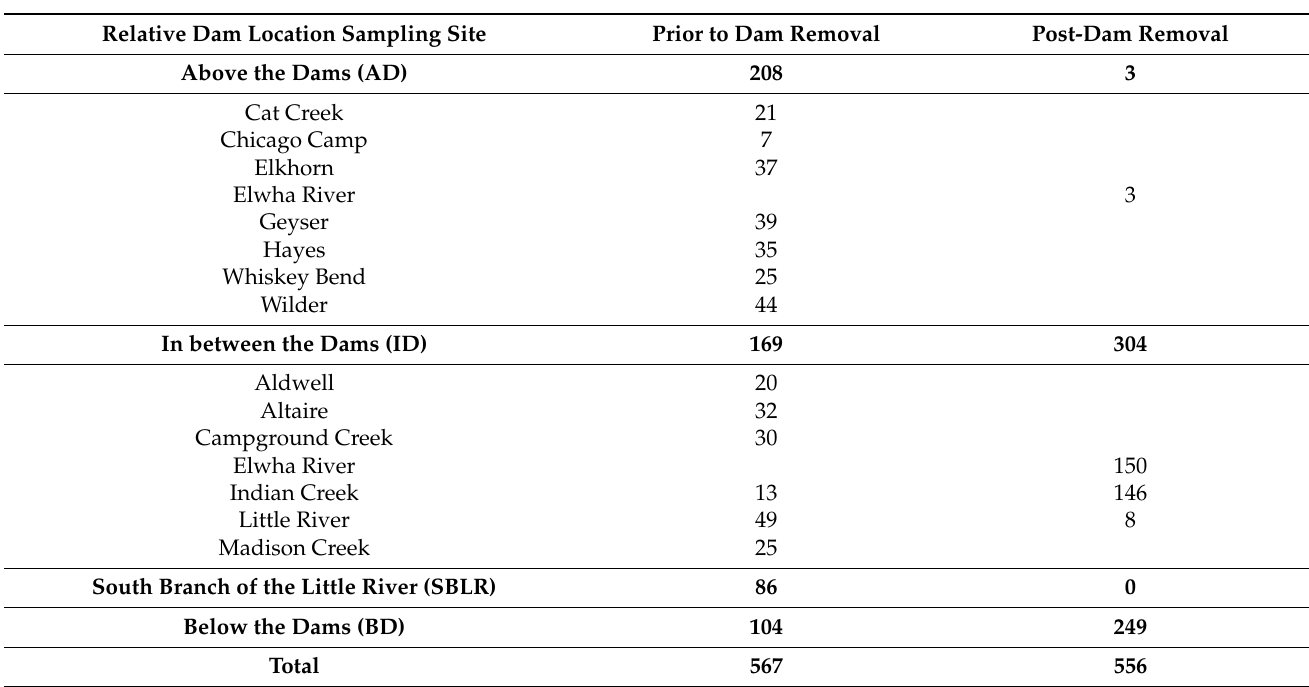
Modified Table 1: Updated table, accounting for updated tallies once metadata errors were corrected. Table 1. All sequenced samples arranged by population (AD, ID, SBLR, and BD) and sampling site, ordered from upstream (top) to downstream (bottom) divided by relative anadromous barrier